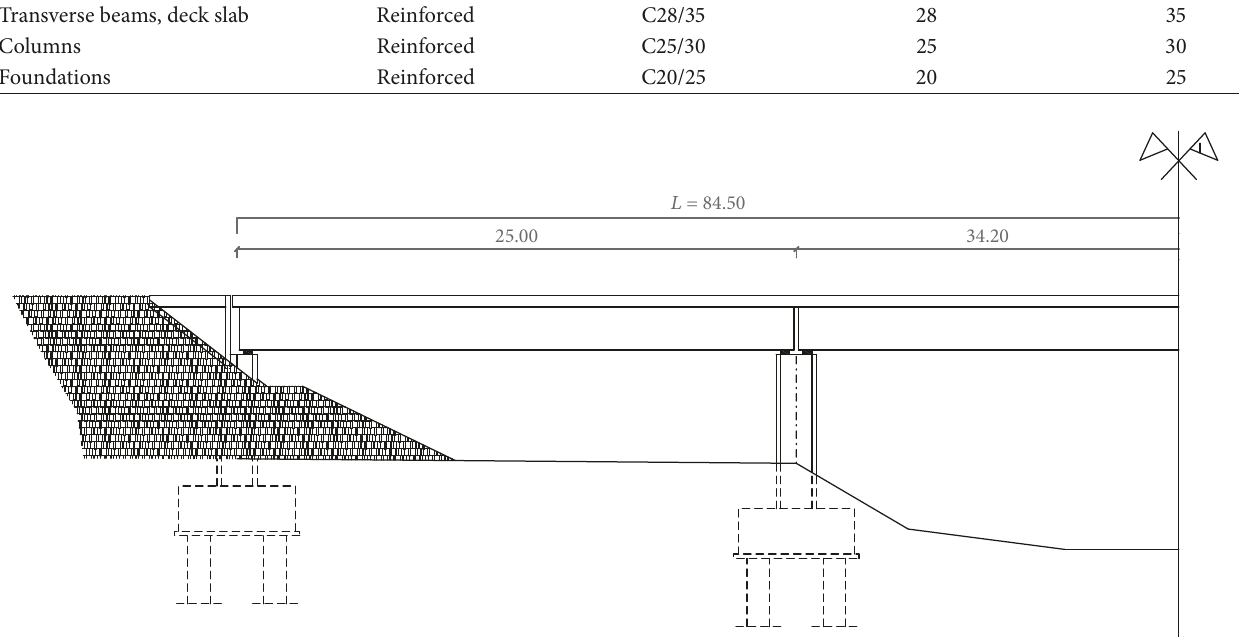
Figure 1: Lateral view of the overall bridge